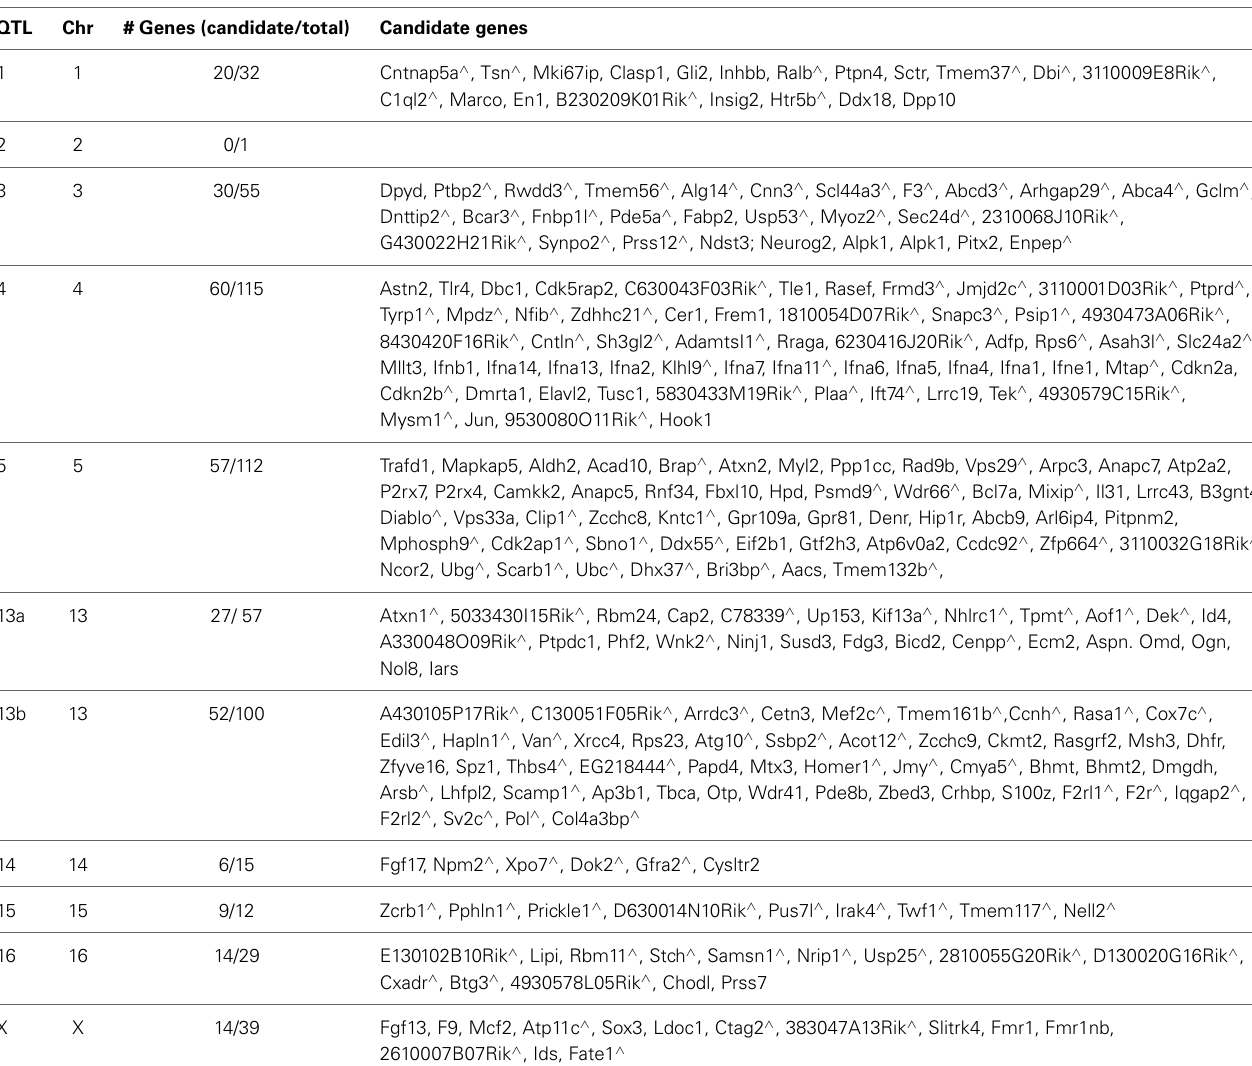
Table 6 | List of candidate